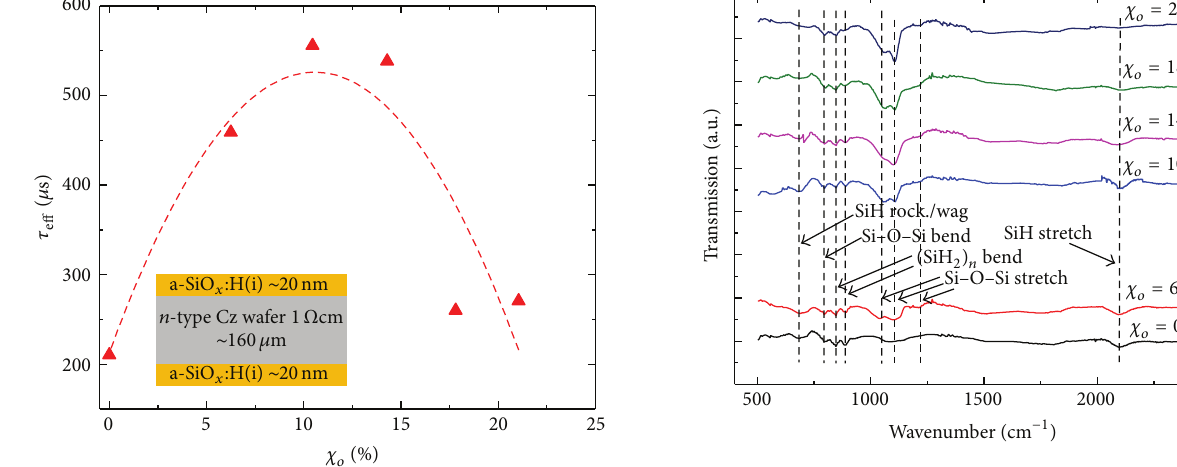
Figure 4: FTIR transmission spectra of a-SiO 𝑥 :H(i) films under different 𝜒 𝑜 .Higher O content in thefilm isobserved withincreasing CO 2 partial pressure, with Si–H(SiO 2 ) being the dominant bonding increases with O content at first due to O configuration. 𝐶 H facilitated inclusion but reduces beyond the optimal 𝜒 𝑜 due to O induced effusion. Doublet at 845 cm −1 and 890 cm −1 shows evidence of low temperature processing. The lines are guides for the